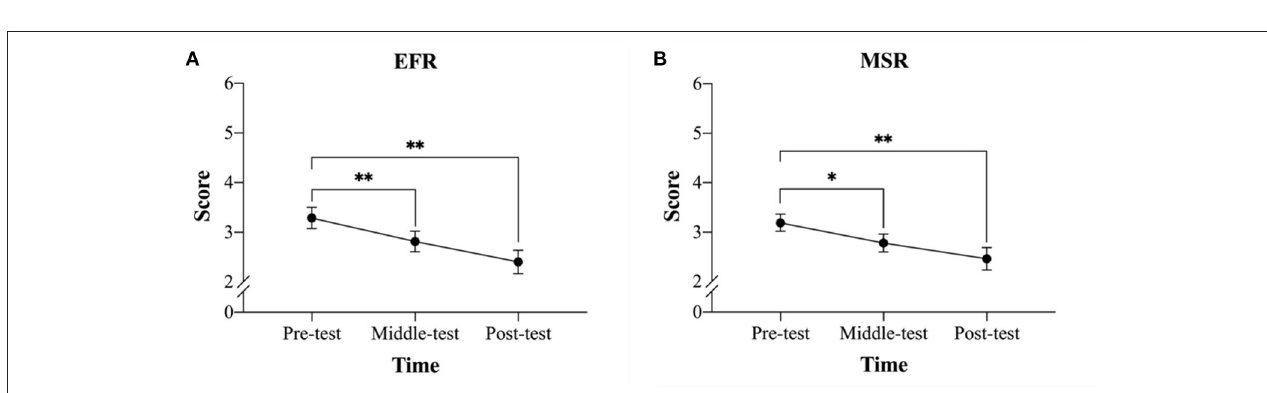
FIGURE 3 | Changes in rumination score across three time points ( M ± SE) before, at the mid-point of, and after the mindfulness-based peak performance (MBPP) program. (A) Comparison of the scores for the emotional-focused rumination (EFR) sub-dimension and (B) comparison of the scores for the meaning-searching rumination (MSR) sub-dimension. * p < 0.05, ** p <